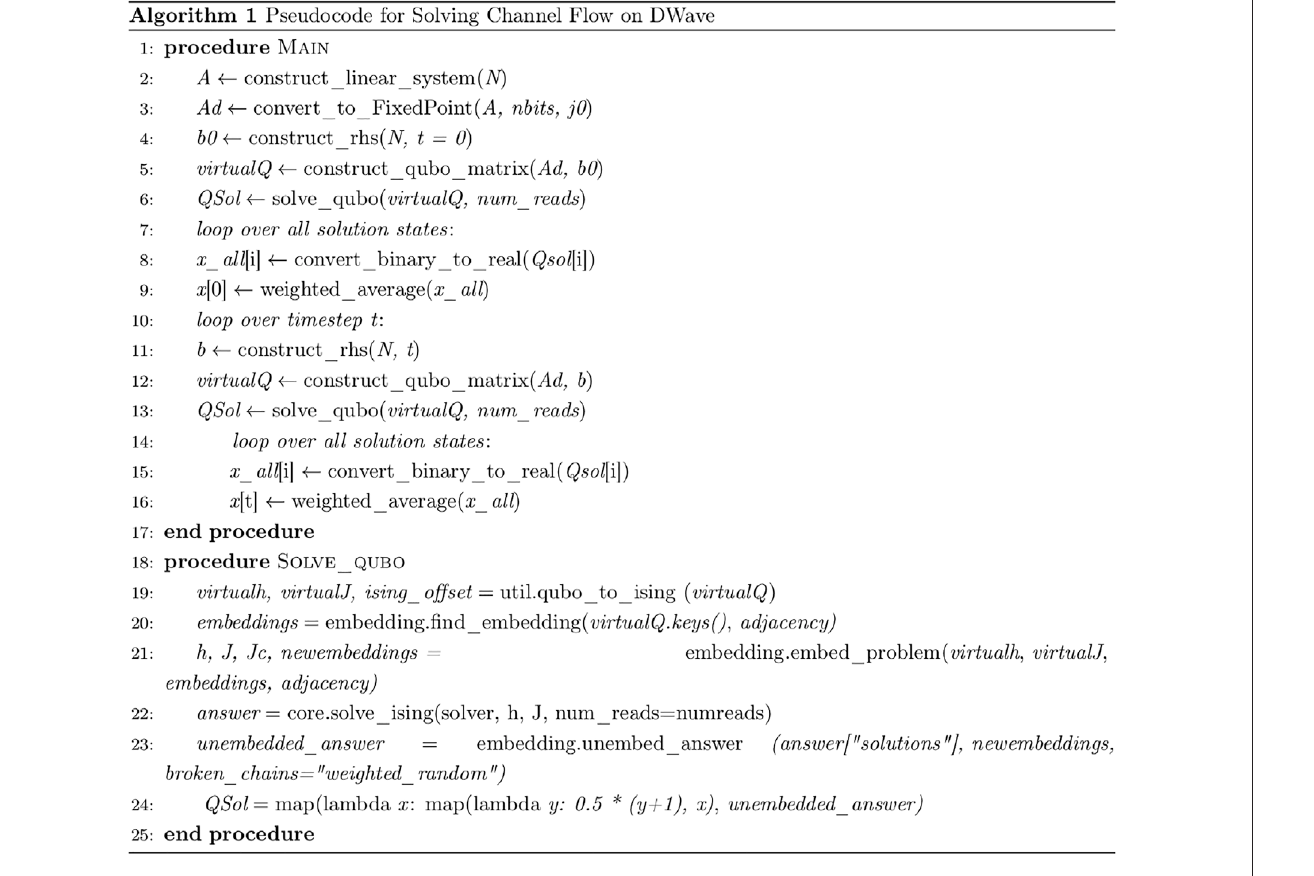
FIGURE 3 | Pseudocode for solving channel fl ow on